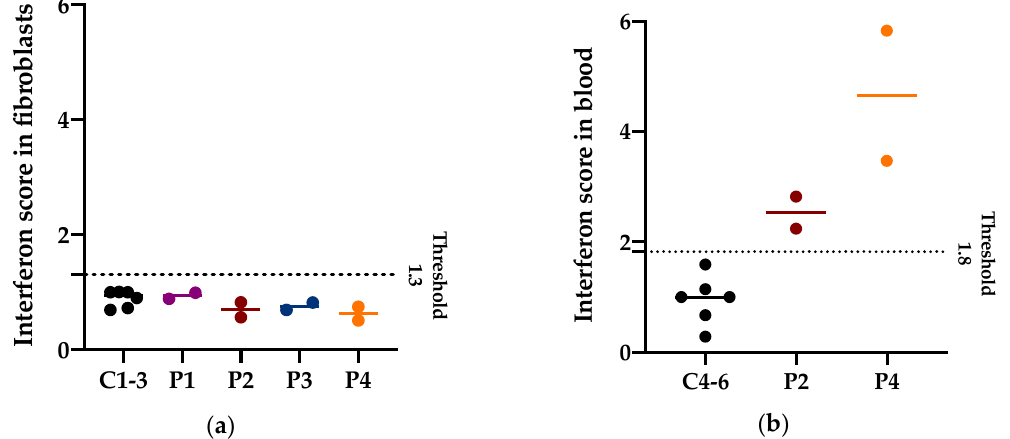
Figure 6. Interferon (IFN) score in fibroblasts and in blood. ( a ) Median and individual values of the IFN score in fibroblasts of three controls and patients with PNPT1 variants (P1–4) from two independent experiments. The IFN score threshold of 1.3 corresponds to the mean IFN score of controls + 2SD. Higher values are considered positive. ( b ) Median and individual values of the IFN score in blood of three controls and patients with PNPT1 variants (P2 and P4) from two independent experiments. The IFN score threshold of 1.8 corresponds to the mean IFN score of controls + 2SD. Higher values are considered positive.